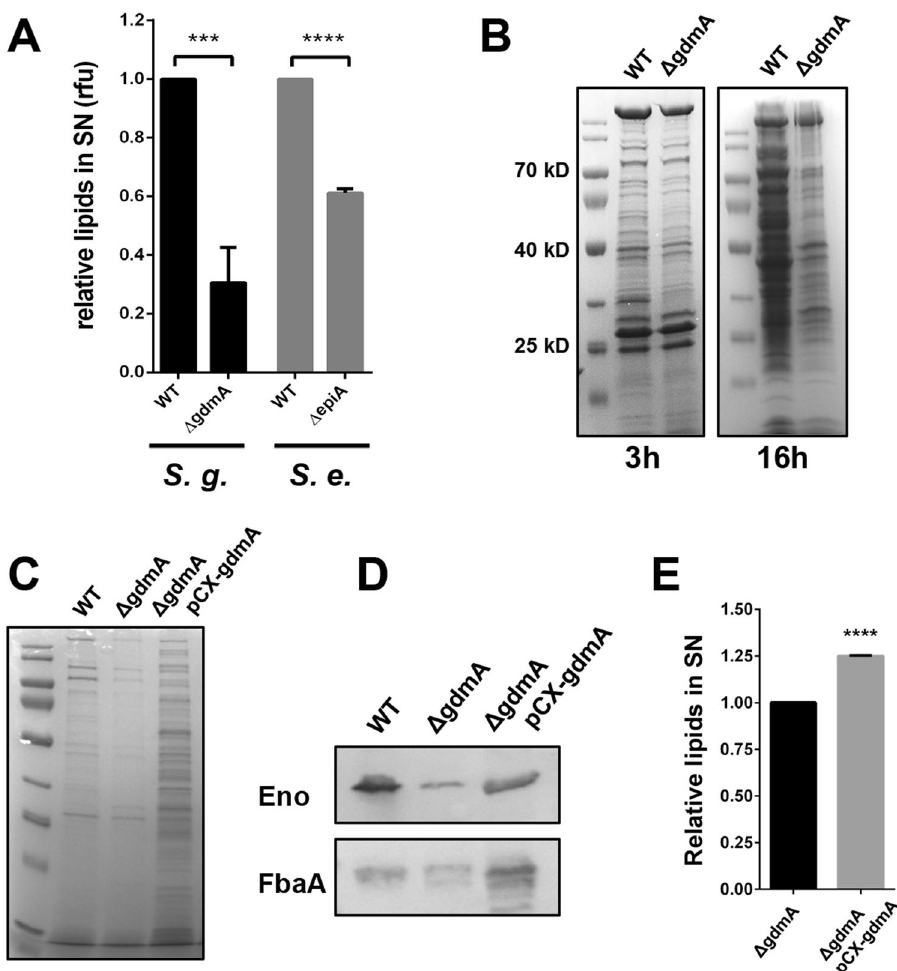
Figure 3. Lantibiotic production causes increased lipid and protein release. ( A ) Relative amount of lipids in S. gallinarum and S. epidermidis parent strains and their lantibiotic-deficient mutants. Amounts of the mutants are normalized to the corresponding parent strain value. Representative data from three independent experiments are shown, each data point is the mean value ± SD *** p < 0.001 **** p < 0.0001 by students t-test. ( B ) SDS- PAGE (Coomassie blue staining) of extracellular proteins of S. gallinarum parent strain and gdmA mutant after 3 h and 16 h of growth. (Uncropped gels are shown in Fig. S1). ( C ) Comparison of the overall protein amount of S. gallinarum parent strain, the gdmA mutant and the complementation pCX- gdmA . ( D ) Western blotting for FbaA Eno and GAPDH in the supernatant of S. gallinarum parent strain, the gdmA mutant and the complementation pCX- gdmA . ( E ) Relative extracellular lipids of the S. gallinarum gdmA mutant and the complementation pCX- gdmA